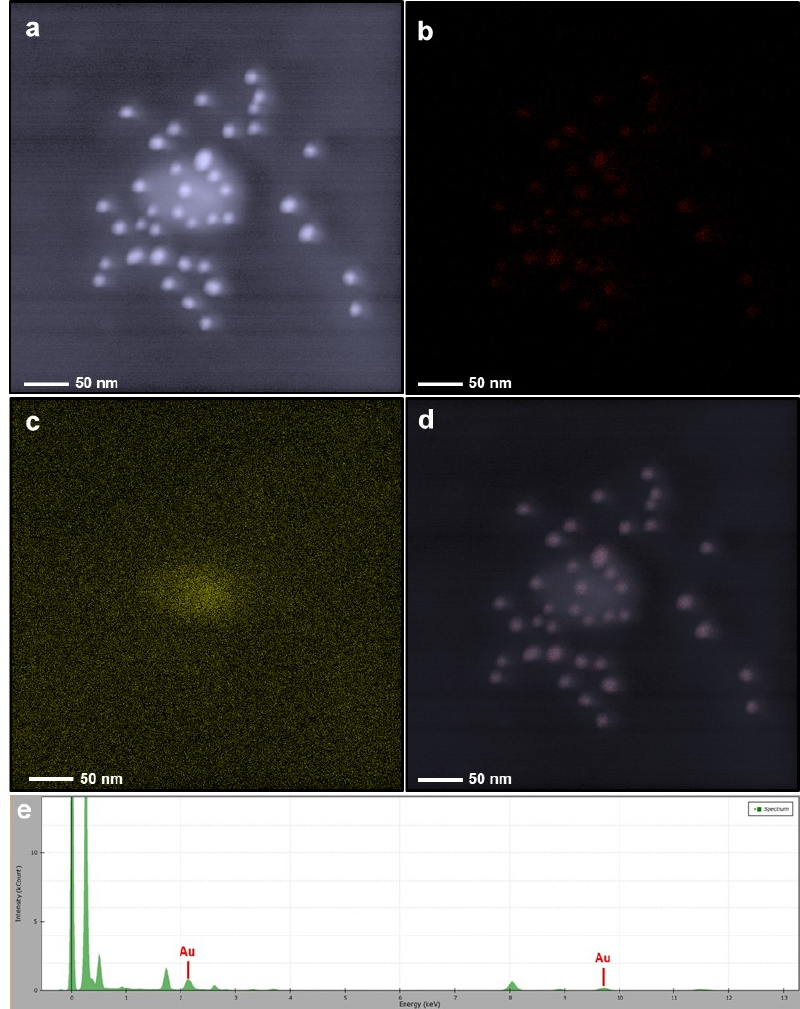
Figure 2. Elemental mapping and energy-dispersive X-ray spectroscopy (EDX) spectrum of the AuNP@30PDOP NP system. Electron micrograph region ( a ), distribution of gold elemental mapping ( b ), distribution of carbon elemental mapping ( c ), overlay of gold and carbon, and ( d ) relevant energy-dispersive X-ray spectroscopy spectrometer (EDAX) spectrum ( e ).